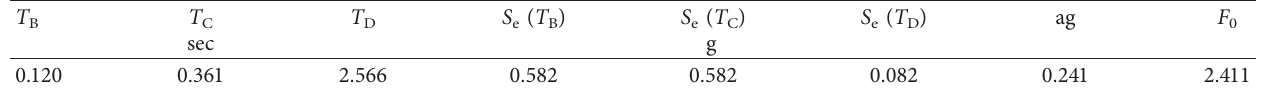
Table 1: Target spectrum parameters.